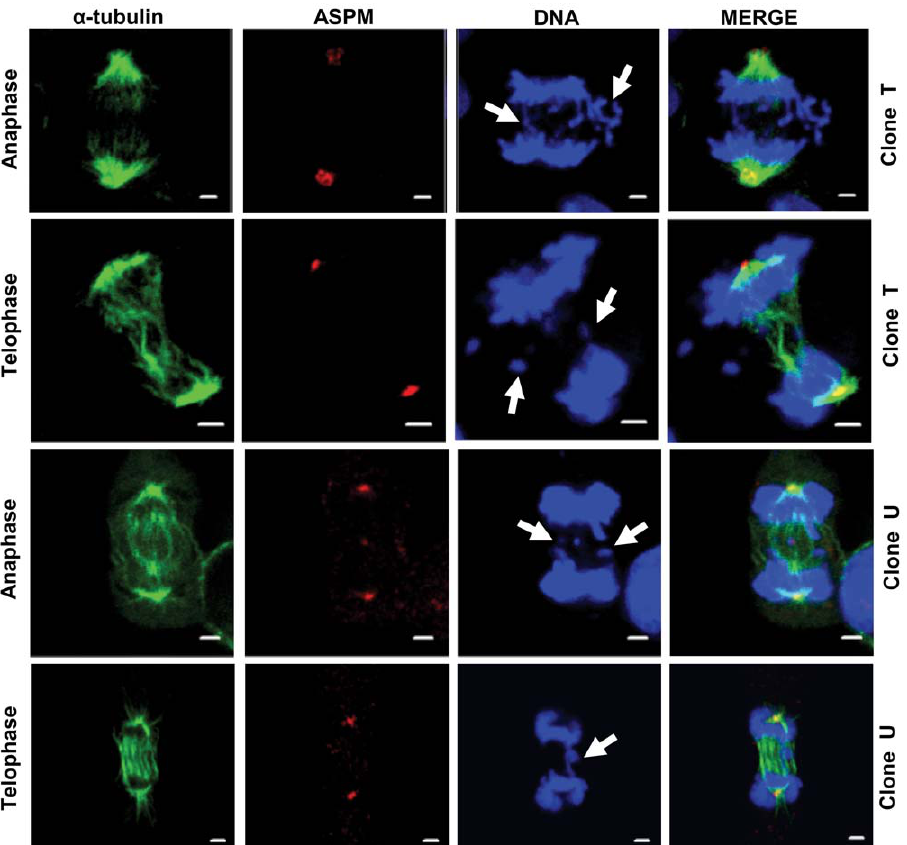
Figure 7. Chromosome segregation defects associated with abnormal spindles in UBE3A shRNA knockdown clones. Examples of cells attempting to divide with missegregated (clone T, anaphase) and lagging chromosomes (clone U, telophase) (arrows). Also note cells with chromosomes hanging at the equatorial plane (clone U, anaphase and clone T, telophase) (arrows). Note the cells have disorganized mitotic spindles (all four panels) and bundling of microtubules at the central spindle (clone U, telophase) and at MTOC (clone T, anaphase). Scale=2 m m.